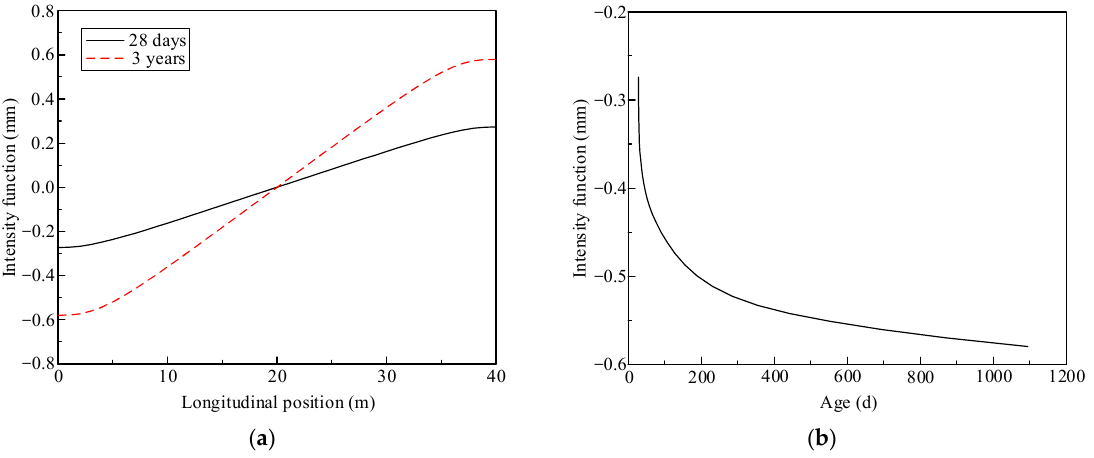
Figure 14. Interface slip of the composite beam (time-dependent analysis). ( a ) Distribution along span; ( b ) Change with time at support section.